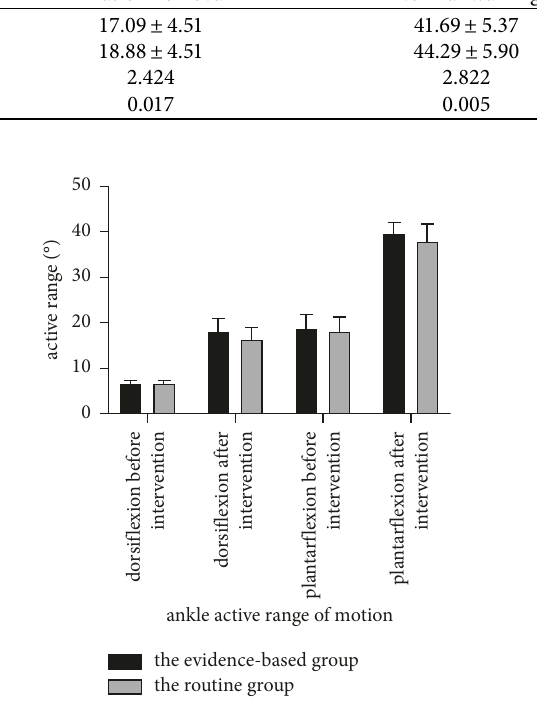
Table 1: Comparison of recovery time between the two groups of patients ( n � 75, d , x ± s ). Group